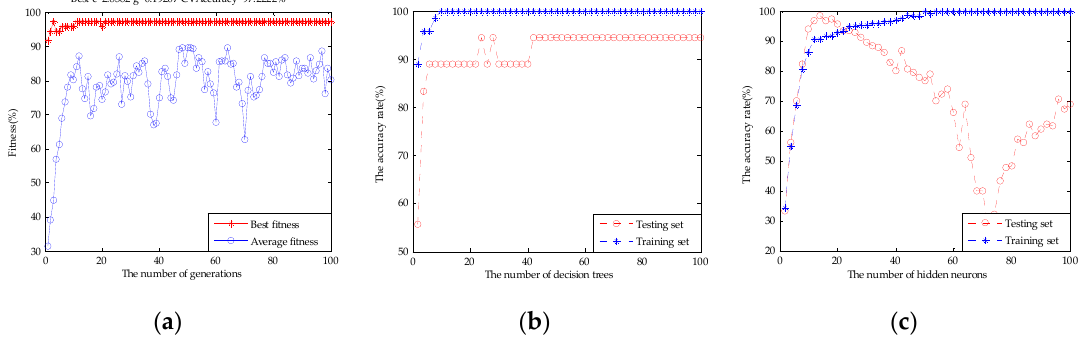
Figure 14. ( a ) The parameter optimization fitness curve of the SVM for subset #12; ( b ) the classification performance of the RF based on the number of decision trees for subset #11; and ( c ) the classification performance of the ELM based on the number of hidden neurons for subset #12.